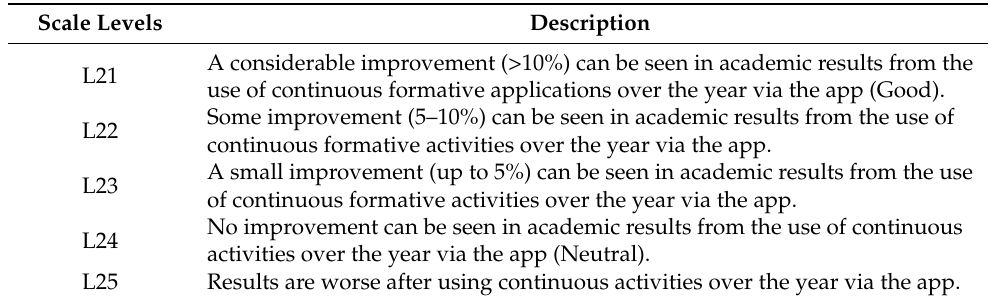
Table 3. Descriptor associated with the Academic performance